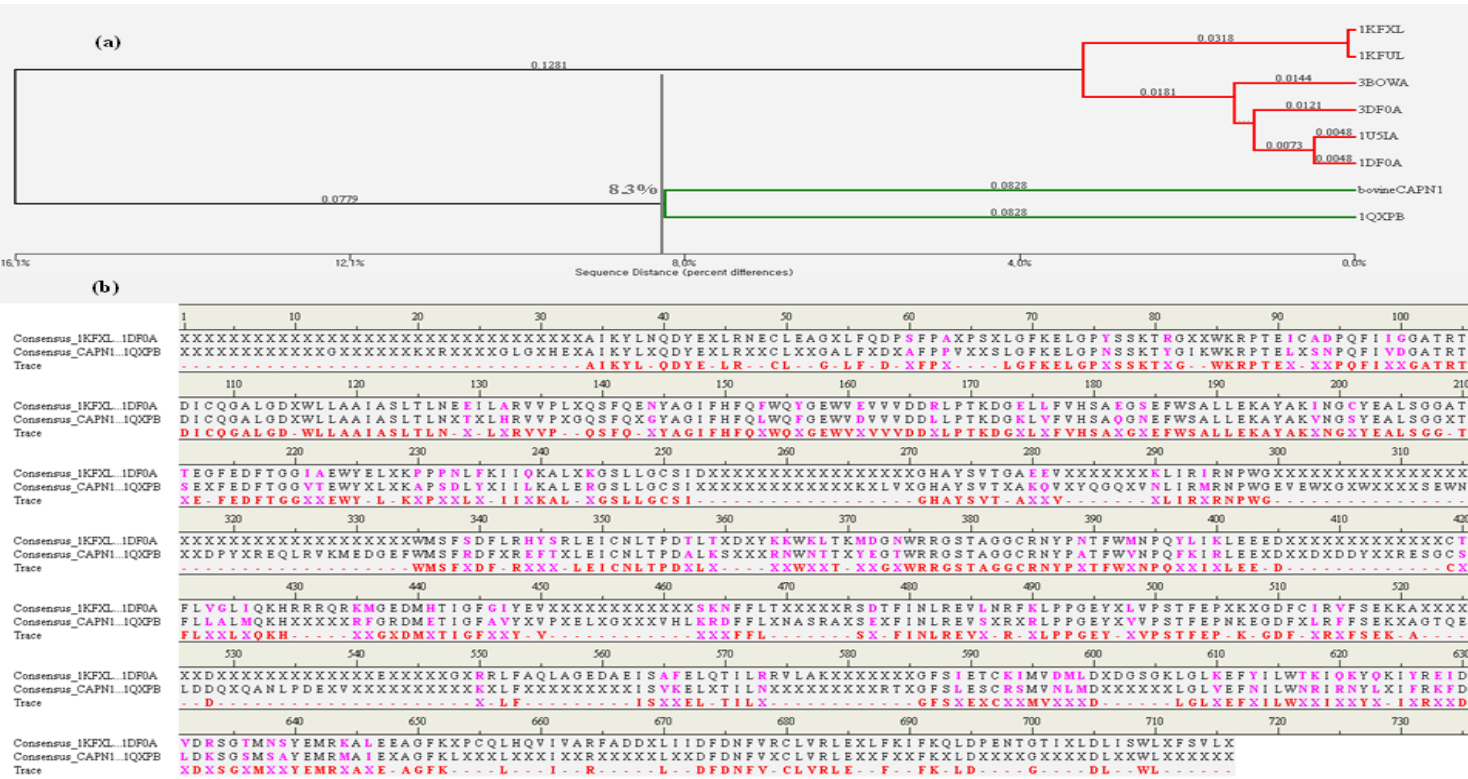
Figure 4. The residue conservation pattern in protein subgroups (CAPN1 and CAPN2) with protein structure: ( a ) A view of similarities in aligned dendrogram sequences with dendrogram, in which the CAPN can be divided into subgroups (CAPN1-green and CAPN2-red) at an 8.3% distance cutoff and ( b ) A segment of CAPN sequence for two subgroups (CAPN1 and CAPN2) for which the conserved residues (red) and class-specific residues (pink) are defined as trace residues from a multiple sequence alignment and a structure alignment based on the cutoff value. To avoid numbering trace residues, all positions are described in terms of the bovine CAPN1 amino acid